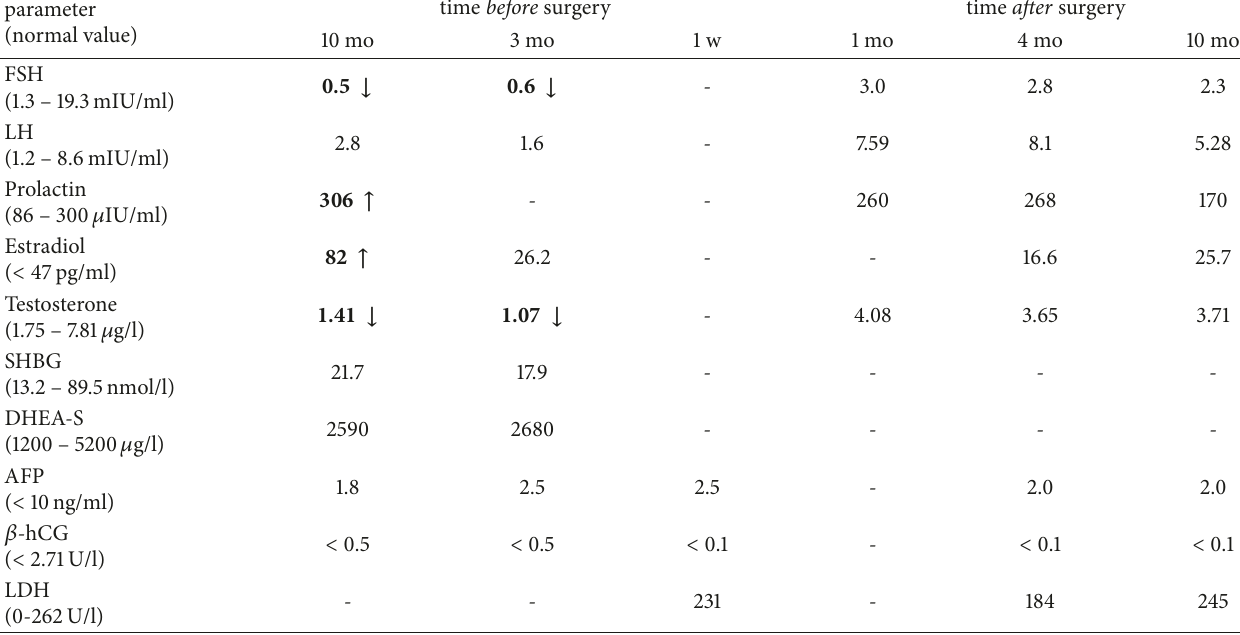
Table 1: Laboratory results before and after surgery. After surgery, secondary hypogonadotropic hypogonadism resolved. (mo: month/months, w: week, FSH: follicle-stimulating hormone, LH: luteinizing hormone, SHBG: sex hormone-binding globulin,